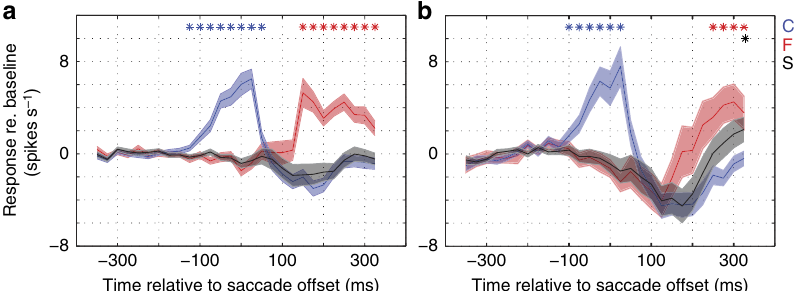
Figure 4 | Temporal dynamics of different types of remapping in V4. ( a ) Average responses to P2 probes flashed at the CF (blue), FF (red) and saccade target location (black) for away saccades ( n ¼ 83). Baseline responses before the probe onset were subtracted from the response curves. ( b ) Responses to P2 probes flashed at the CF (blue), FF (red) and saccade target location (black) for towards saccades ( n ¼ 54). Stars indicate responses that were significantly above baseline (one sample t -test, P o 0.05) and shades represent s.e.m. across the respective population of